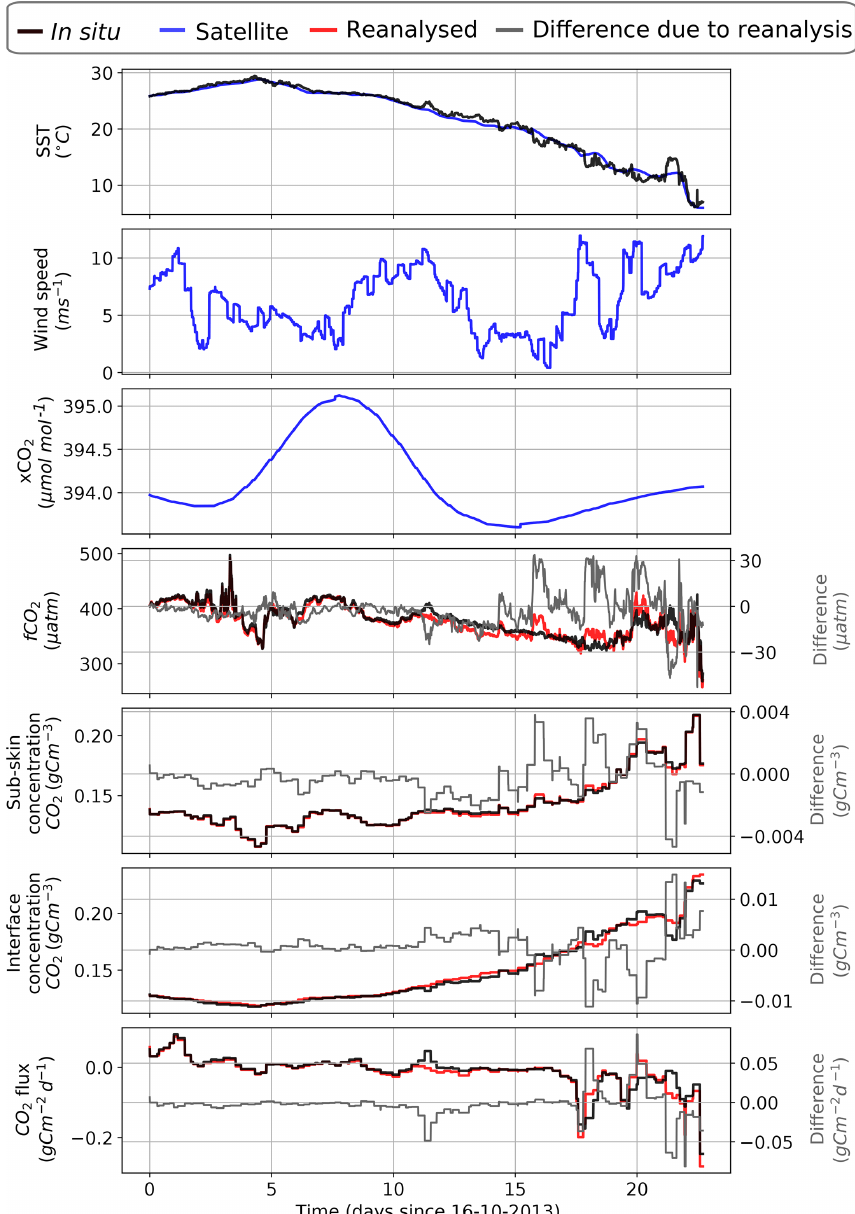
Figure 4. Time series of the (Kitidis and Brown, 2017) in situ campaign data with the sea-to-air CO 2 flux as calculated by FluxEngine using the Ho et al. (2006) gas transfer velocity parameterisation. The results from the reanalysed f CO 2 values are shown in red to distinguish them from the original data. The differences in f CO 2 , sub-skin, and interface CO 2 concentration, and sea-to-air CO 2 flux, resulting from the reanalysis, are shown in grey (reanalysed minus